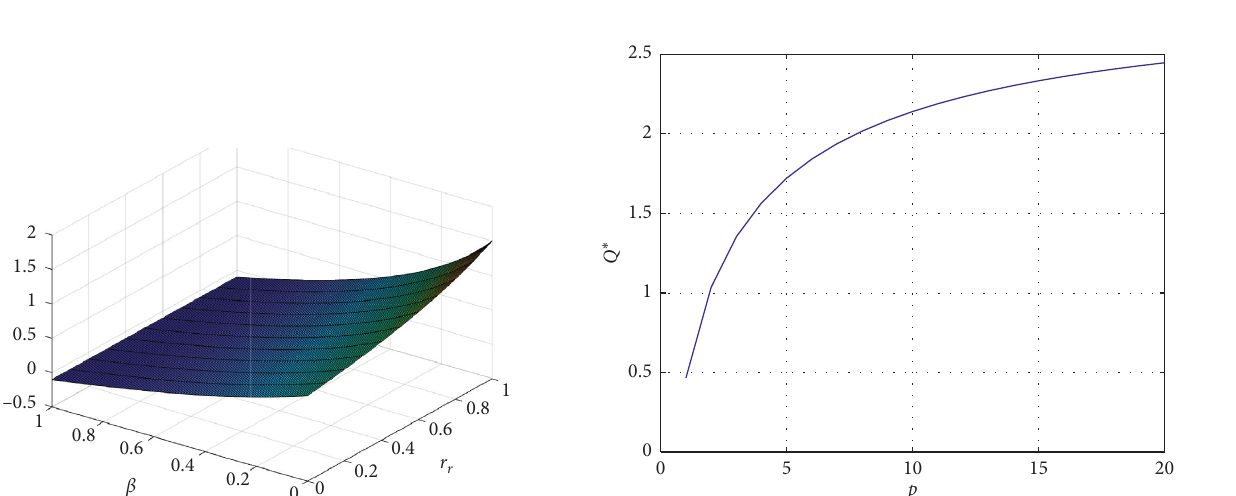
Figure 4: Effect of risk level β and unit shortage cost b on the optimal inventory quantity Q ∗ under RMI mode with stochastic demand in the water supply chain.